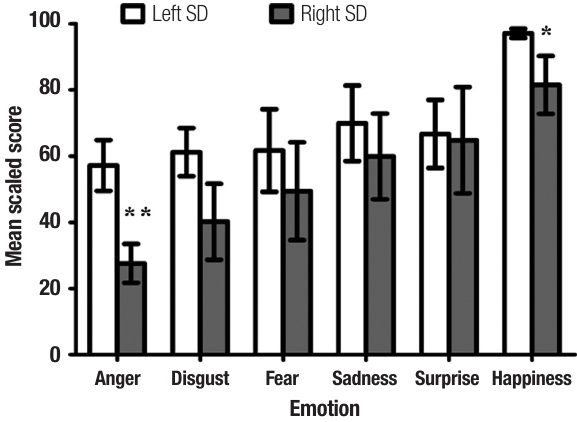
Figure 2. Performance of left and right SD cases on the Ekman 60 emotion recognition task. Scores for SD cases are represented as percentages of control performance. Ekman 60 data available for 9 right SD patients. Error bars depict standard error of the mean. *p<0.05;